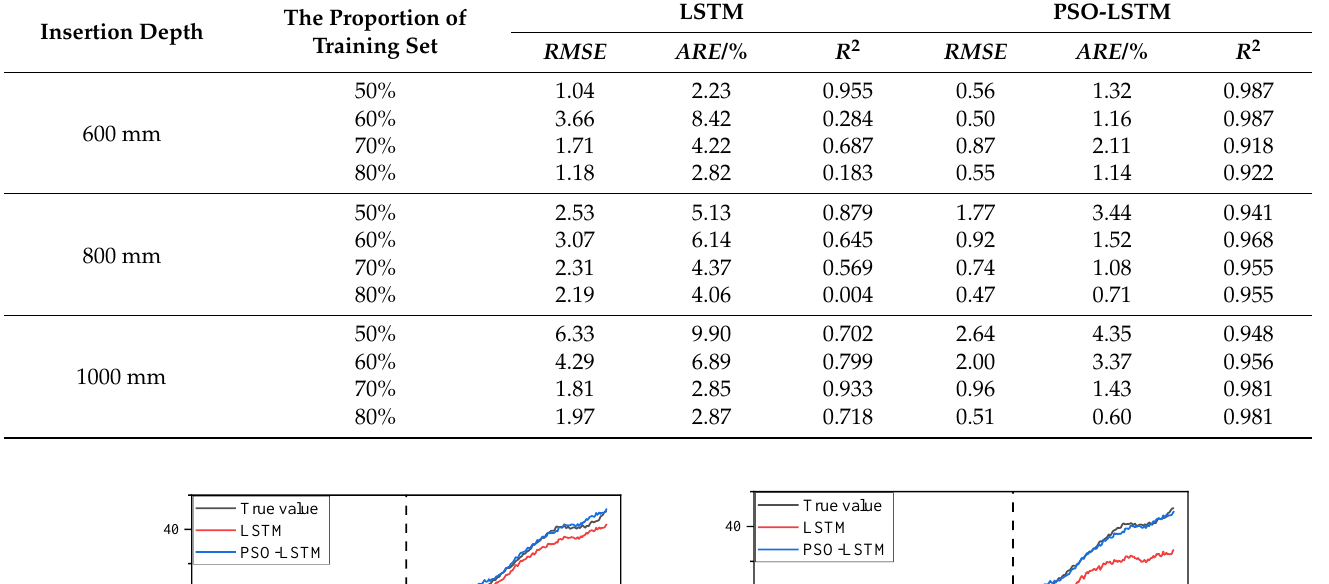
The prediction performance of the LSTM and PSO-LSTM models for inserting sand samples with depths of 600 mm, 800 mm, and 1000 mm are shown in Figures 20 – 22.